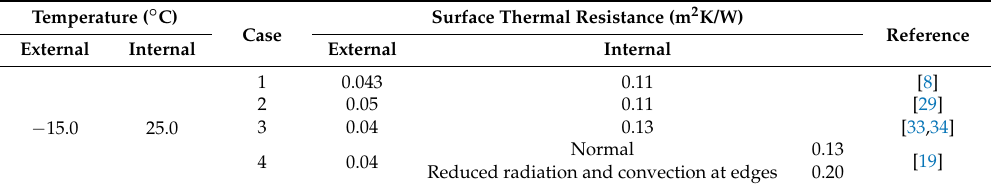
Table 2. Simulation cases and boundary conditions.